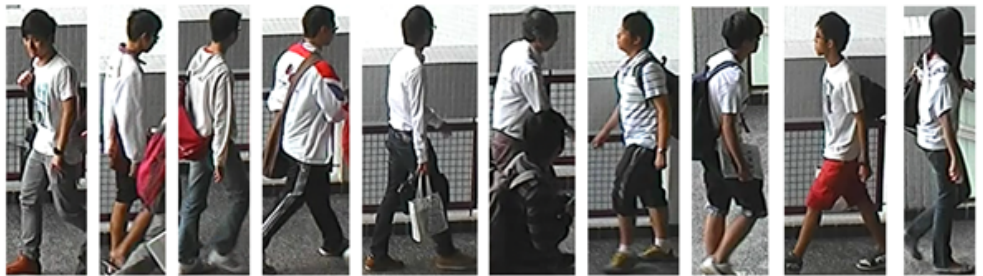
Figure 7. Search results for a request to find ten people wearing white